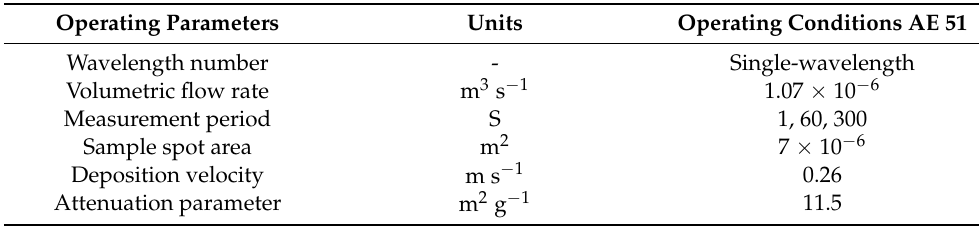
Table 1. Operating conditions for